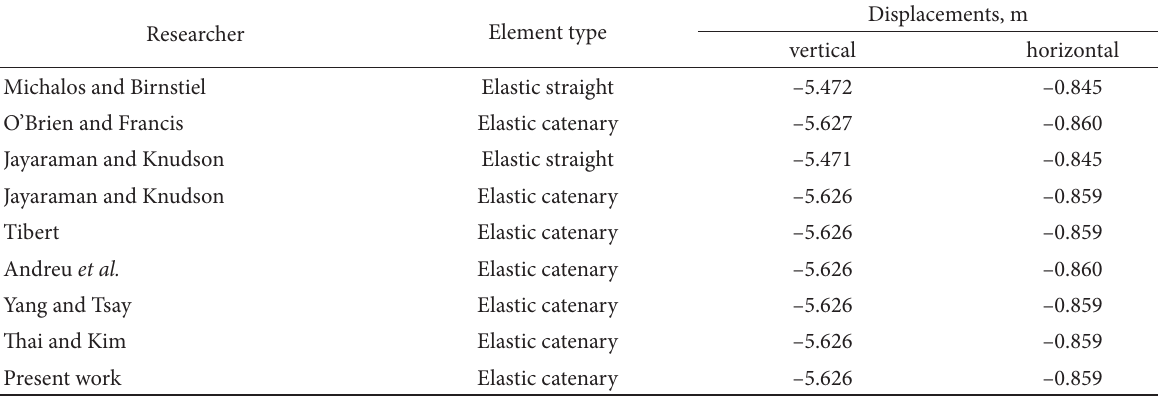
Table 2. Comparison of displacements of isolated cable under concentrated